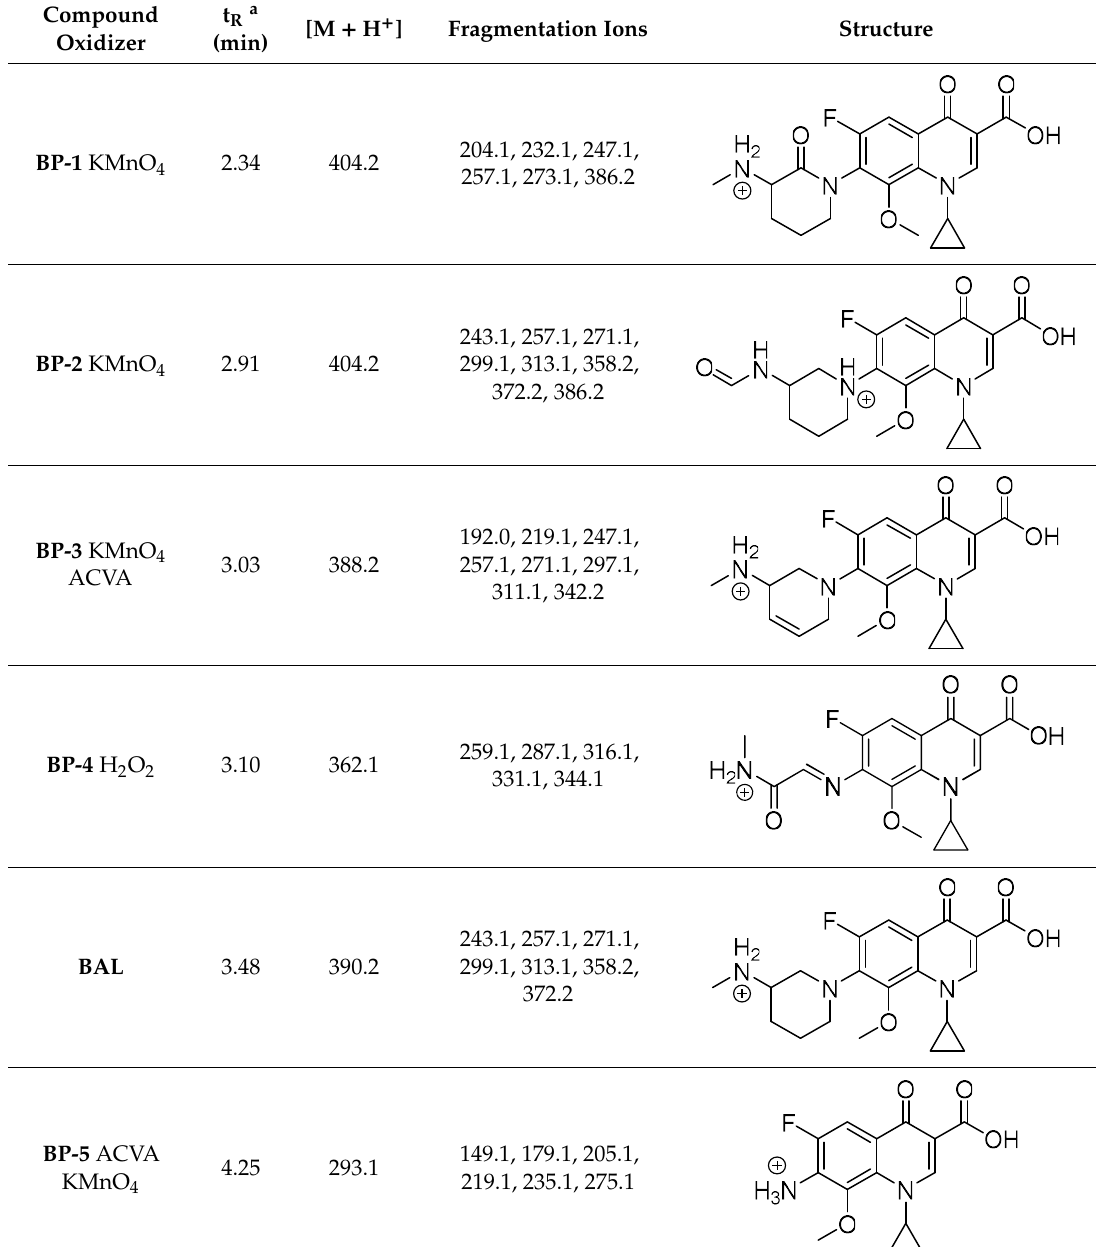
Table 4. Proposed structures of the degradation products of BAL.